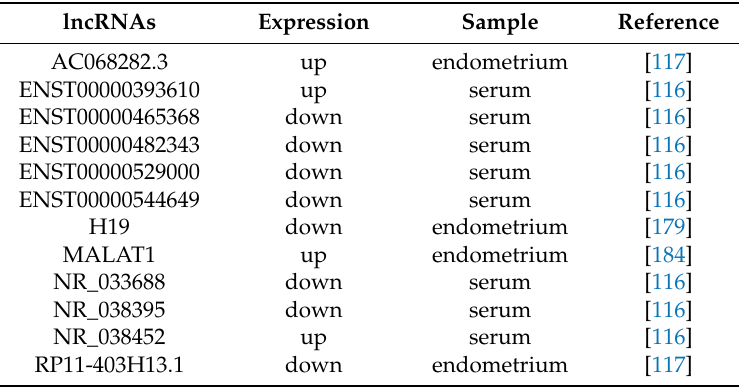
Table 5. lncRNAs differentially expressed in Endometriosis